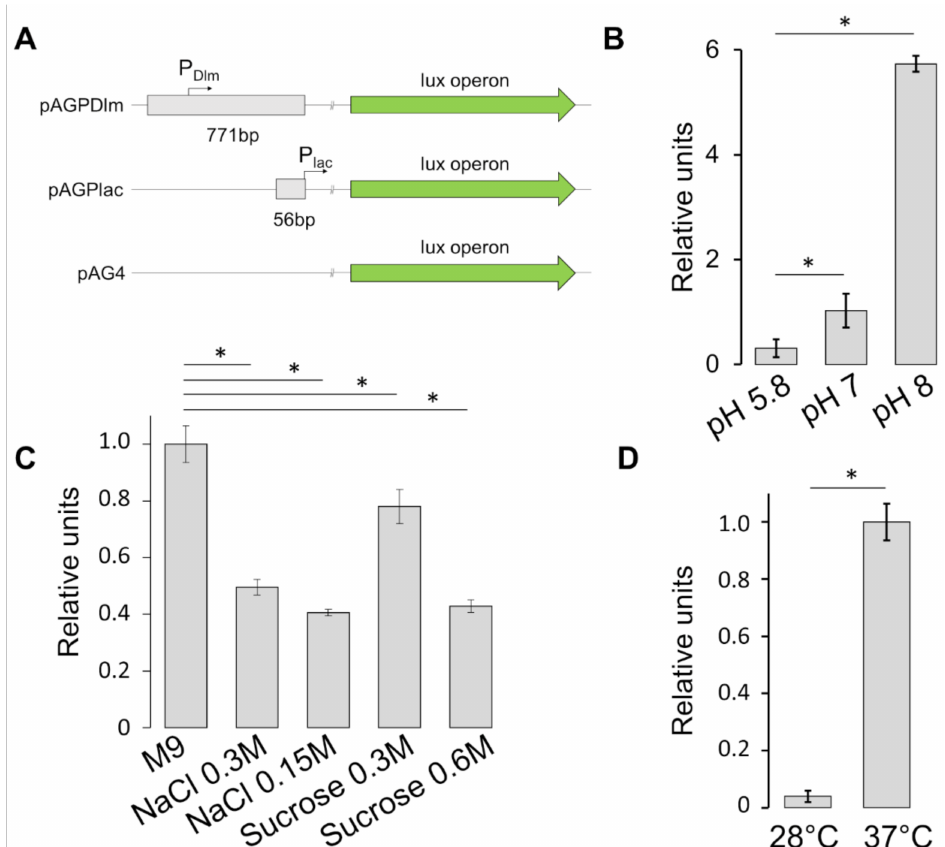
Figure 6. Expression of the DLP12 lysis module in response to stress conditions. ( A ) Schematic representation of pAGPDlm, pAGP lac and pAG4 constructs. PDlm activity as a function of pH ( B ), osmolarity ( C ) and temperature ( D ). Vertical bars indicate the standard deviation of three independent experiments. Statistical significance was determined by the t test, and p values are as follows: * p <